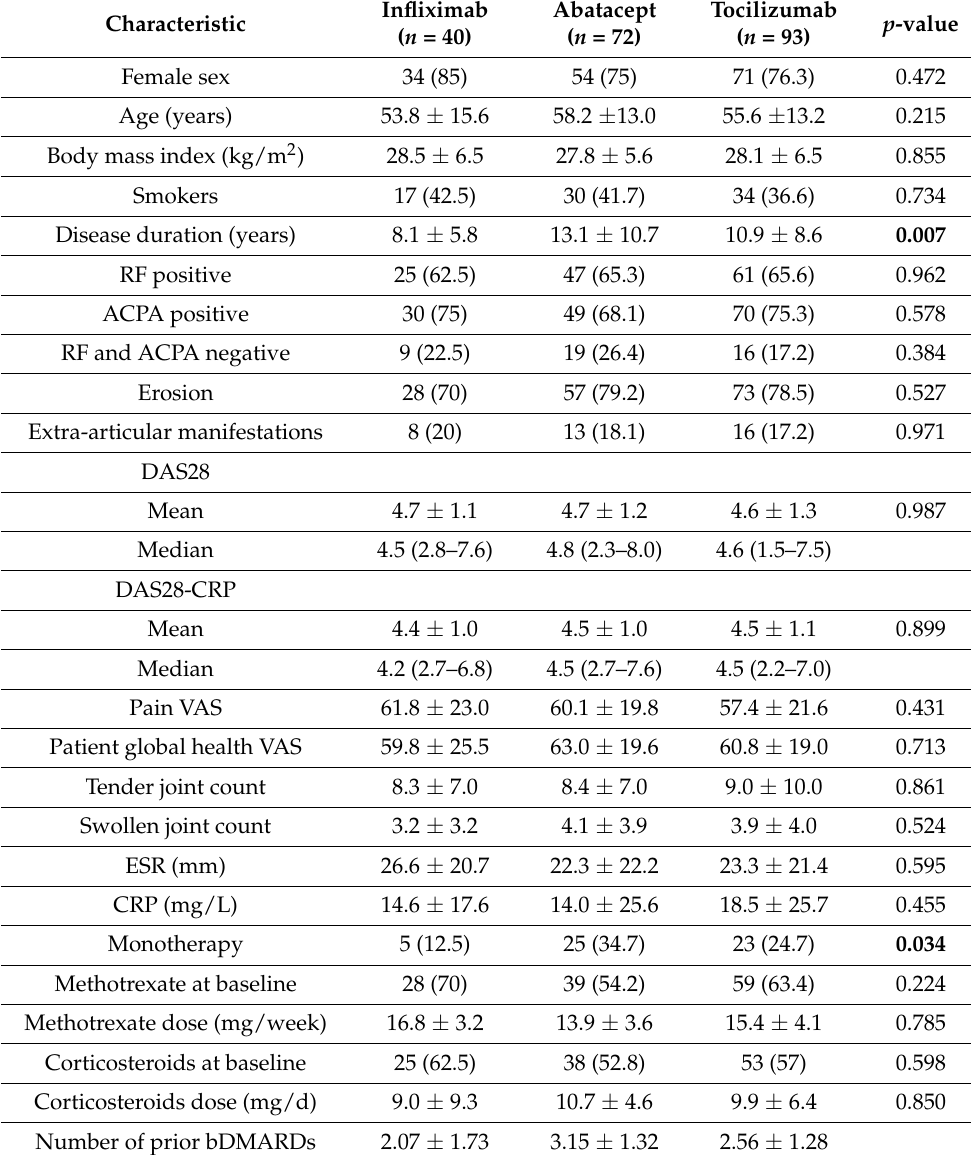
Table 1. Characteristics of the 205 RA patients and bDMARD